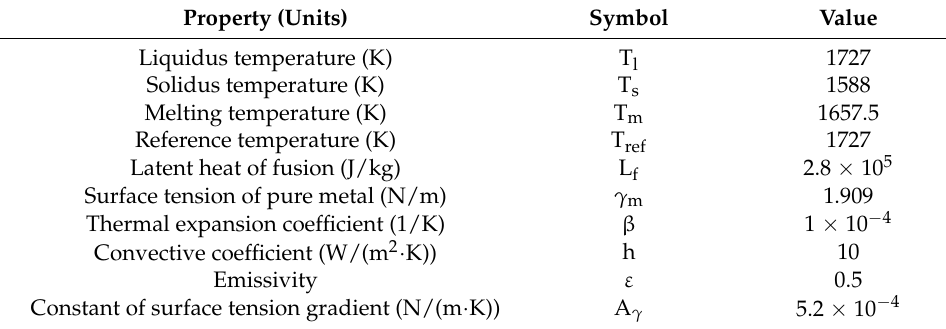
Table 3. Simulation parameters of